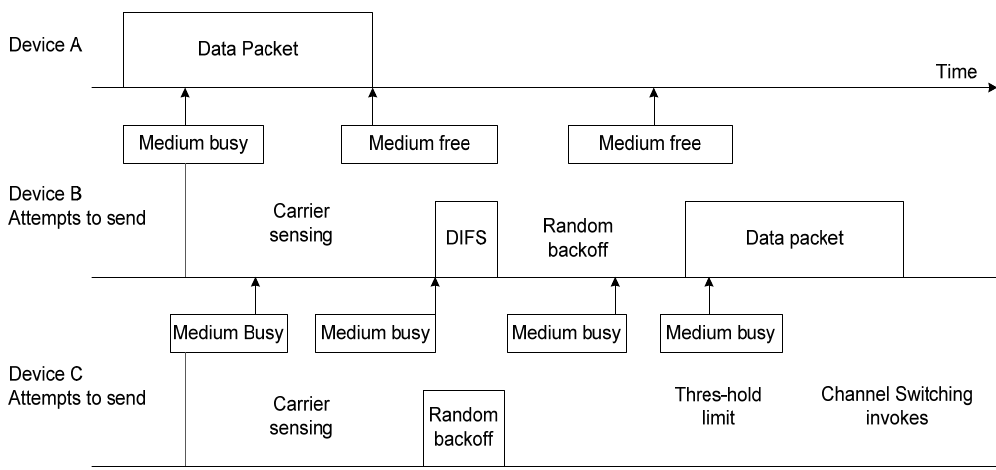
Figure 4. Contention period and channel